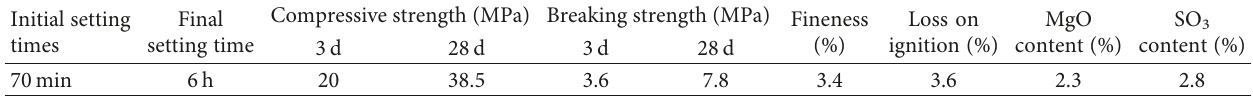
Table 1: P.O 42.5 R Portland cement quality performance metrics.